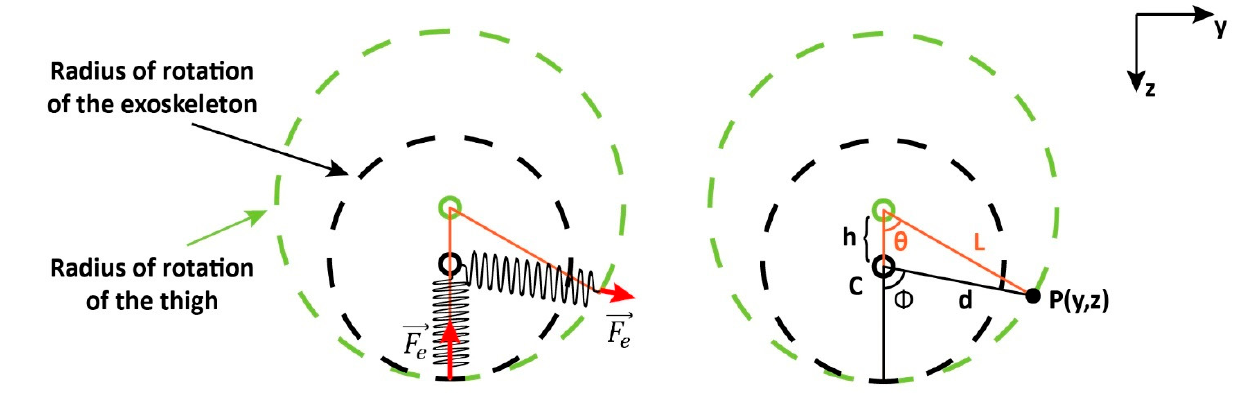
Figure 3. Dual behaviour of the exoskeleton—lateral view.